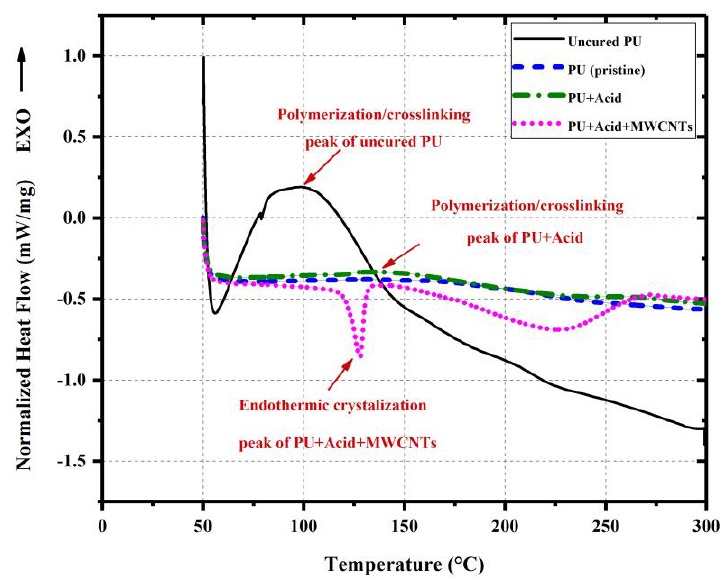
Figure 10. Differential scanning calorimetry (DSC) curves of PU specimens.